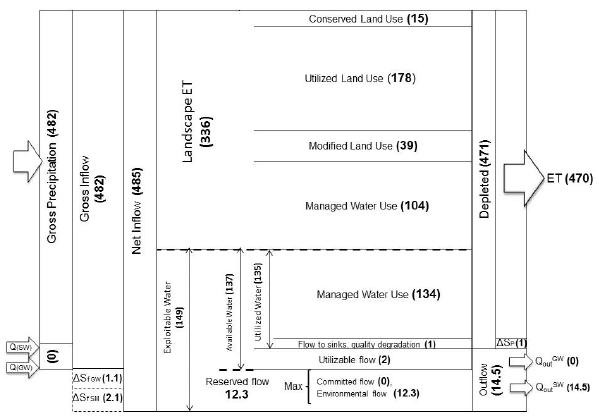
Figure 7. Impact of scenario B on WA+ resource base sheet for the Indus. All components are in 3 Fig. 7. Impact of scenario B on WA + resource base sheet for the km 3 4 Indus. All components are in km 3